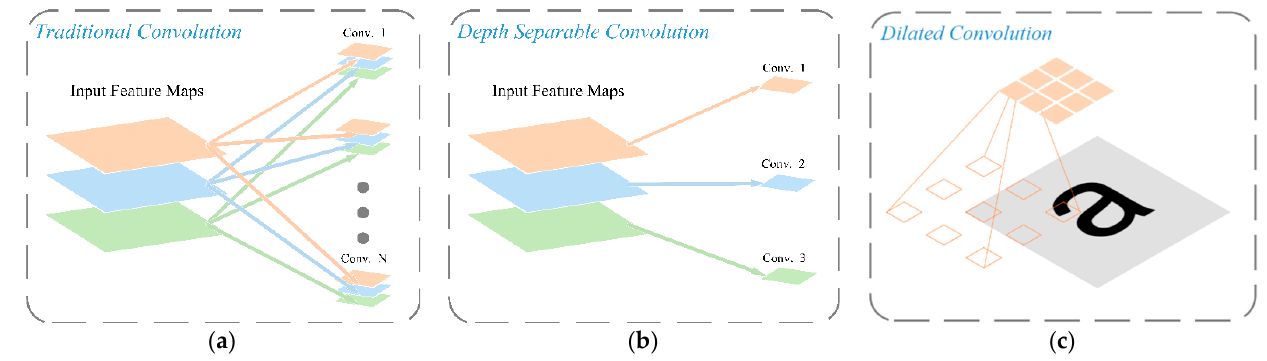
Figure 7. Comparison of some new convolution kernels. ( a ) Traditional convolution kernel. ( b ) Depth-separable convolution kernel. ( c ) Dilated convolution.